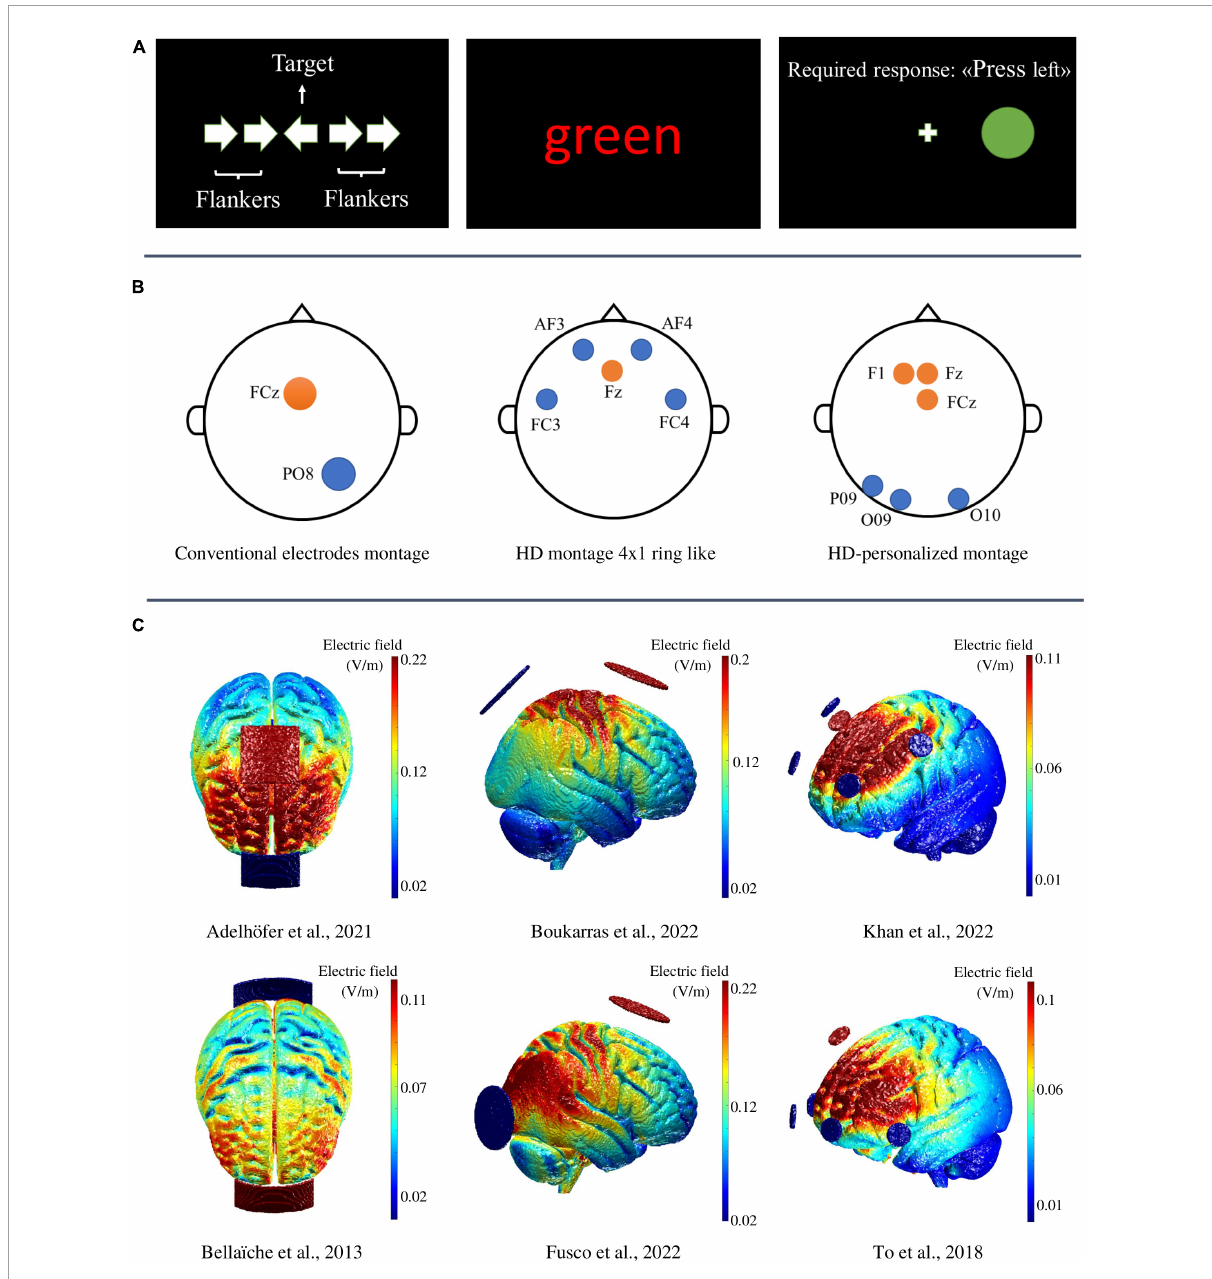
FIGURE1 The upper panel (A) displays examples of incongruent trials of the Arrow-Flanker, Color–Word Stroop, and Simon task, respectively. In the Flanker task conflict occurs when the flankers are dissimilar from the target (e.g., the flanking arrows point in the opposite direction than the target) and compete for activating different stimulus-motor representations. In the Stroop task, the conflict arises because participants must suppress the involuntary processing of a task-irrelevant attributes (i.e., the meaning of the color word) and attending for less automatically processed task-relevant attributes (i.e., the color in which the word is printed). Finally, in the Simon Task participants are asked to respond to a lateralized target (e.g., by pressing the left button when a green circle appears), irrespective of the effective spatial position of the target. Here, the conflict arises when the spatial position of the target and the response side do not correspond (i.e., the green circle appears on the right). The middle panel (B) displays three examples of electrodes’ montage in transcranial alternating current stimulation studies (from left to right, Fusco et al., 2022; Khan et al., 2022; and Mattavelli et al., 2022). The lower panel (C) shows three different views of 3D cortical maps representing the electric field intensity distribution (simulated through the open-source software ROAST; https://www.parralab.org/roast/; Huang et al., 2019) of six tES experimental studies differing for both the employed electrodes sizes and montages; from left to right: (i) the axial views of two transcranial direct current stimulation (tDCS) studies both employing a conventional bipolar tDCS montage with two rectangular electrodes of 25 cm 2 (Adelhöfer et al., 2021) and 35 cm 2 (Bellaïche et al., 2013); (ii) the saggital views of two transcranial alternating current stimulation (tACS) studies employing a conventional tACS montage with two circular electrodes of 25 cm 2 ; (iii) the antero-sagittal views of two HD-tDCS studies both employing a 4 returns × 1 active ring-like